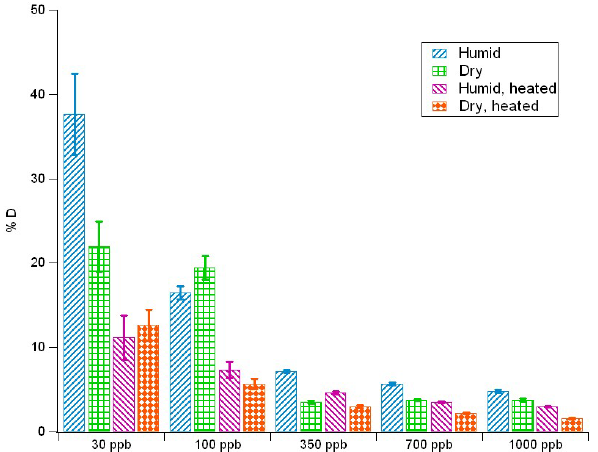
Fig. 5. D-factor illustrates the extent of NH 3 surface interaction at a range of NH 3 mixing ratios under conditions of dry and humidi- fied air and using a heated line. The relative contribution of surface interactions is higher at lower mixing ratios, under humid condi- tions and without the use of a heated line. Error bars indicate one standard deviation.